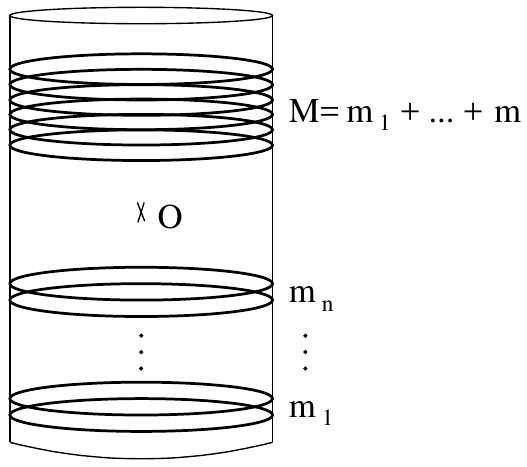
Figure 1 . Joining of n component strings to form one single